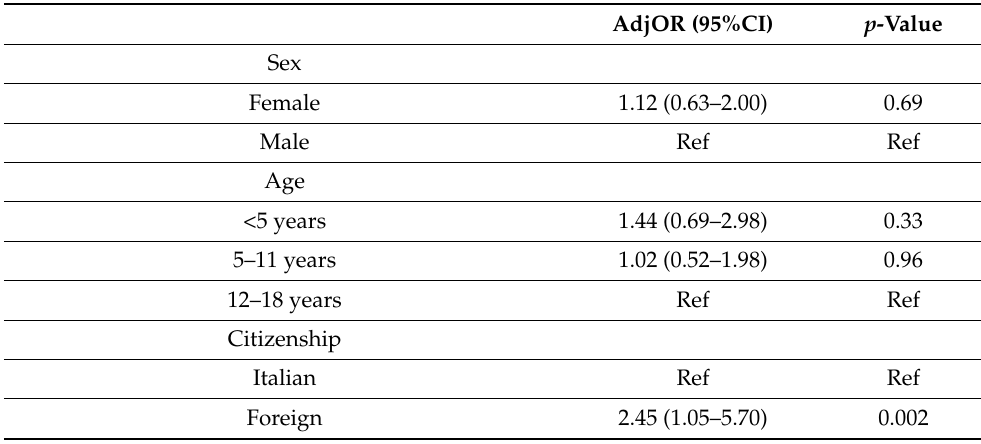
Table 4. Multivariate logistic regression of factors associated with positive anti-SARS-CoV-2 IgG antibodies (n =